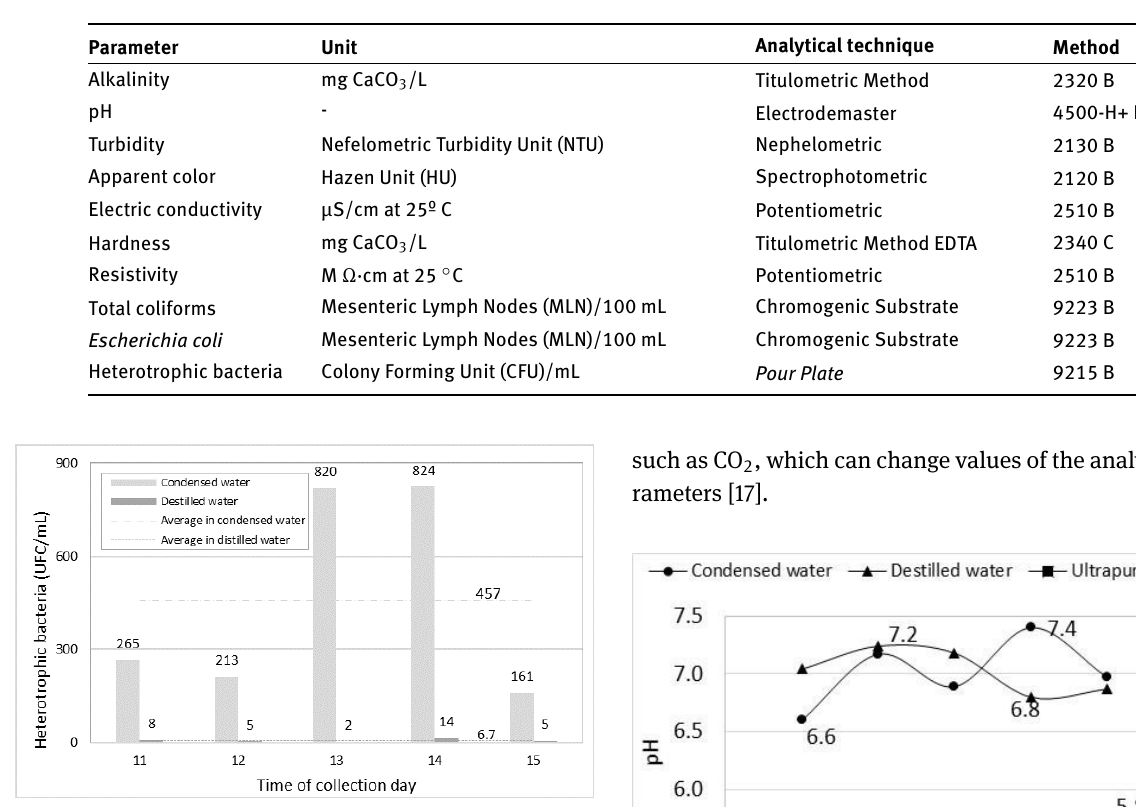
Table 1: Physicochemical and microbiological parameters analyzed, as well as the analytical techniques used according to Standard Meth- ods [8].